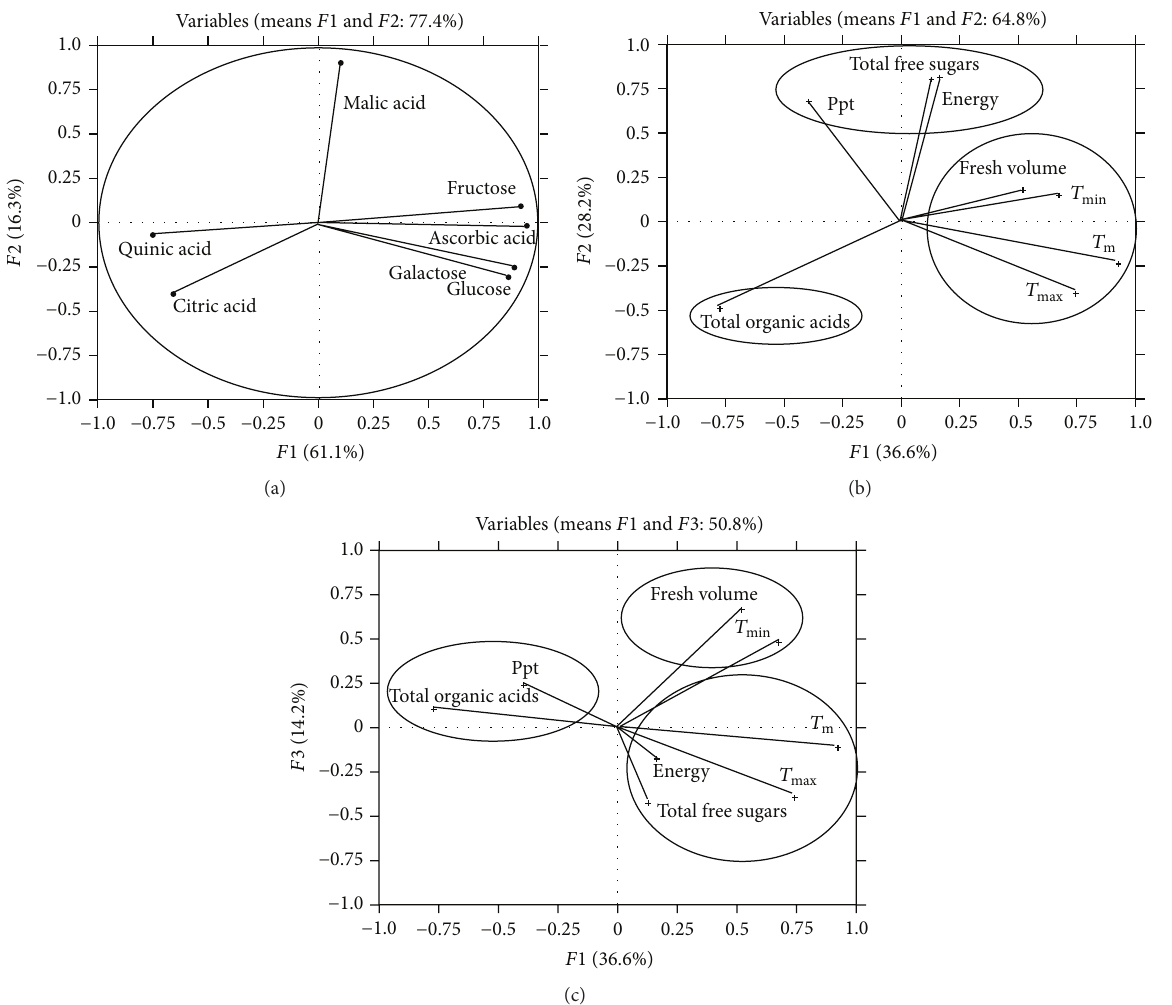
Figure 2: (a) Principal Component Analysis (PCA) obtained by analysis of free sugars, organic acids, and vitamin C data for four blueberry cultivars harvested in 2011–13. ((b) and (c)) Principal Component Analysis (PCA) obtained by analysis of total free sugars, total organic acids, fresh volume, Ppt (quantity of rainfall), 𝑇 m (mean temperature), 𝑇 max (maximum temperature), and 𝑇 min (minimum temperature) data for four blueberry cultivars harvested in